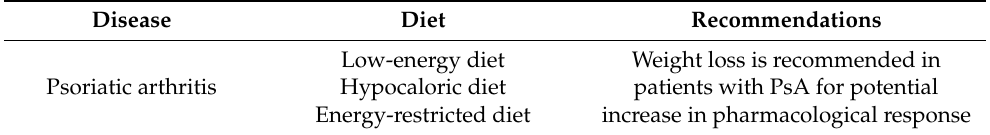
Table 4. The 2018 American College of Rheumatology/National Psoriasis Foundation Guideline for the Treatment of Psoriatic Arthritis